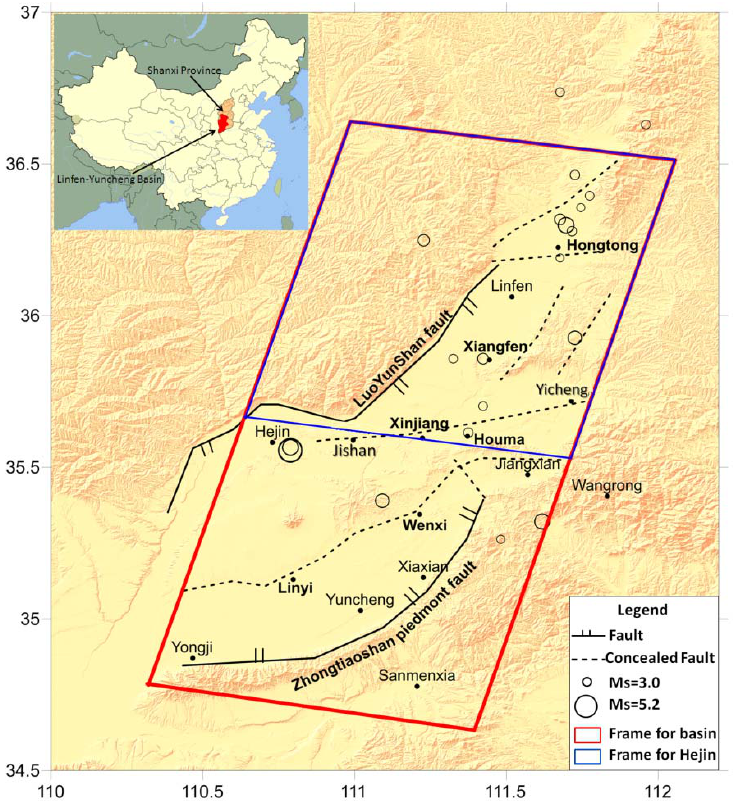
Figure 1. Shaded relief map of the Linfen–Yuncheng